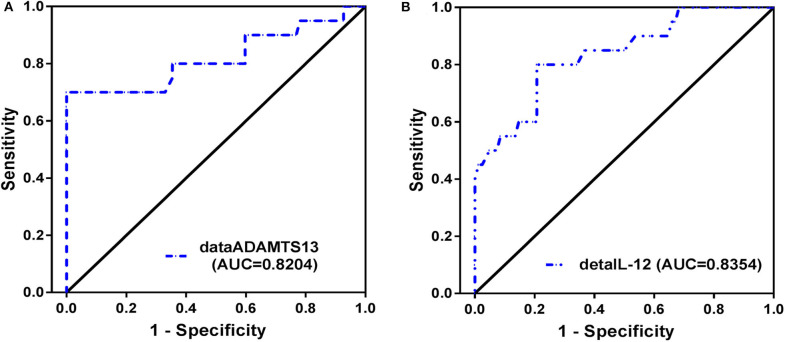
Receiver operating characteristic (ROC) curves. The ROC curves of the Δ (delta) ADAMTS13 (A), ΔIL-12 (B) after 1 year of m-ETV treatment for separating HBeAg SC from non-SC in HBeAg (+) CHB patients with 96 weeks of continuous m-ETV treatment.